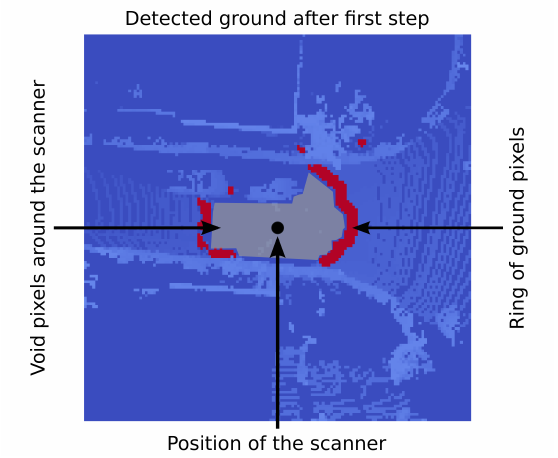
Figure 3. A zoom of the image I max : in a narrow street, the road in front of the car is disconnected from the rear. In red, pixels in the closest ring around the scanner are detected as ground. Figure 4. The distance between points and the scanner depend on the tangent of the inclination angle ( φ i ) of the layer i and the scanner height h